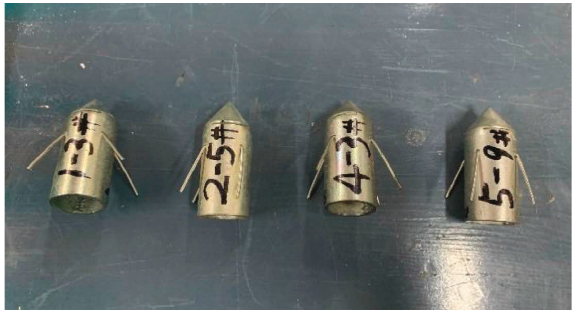
Figure 15: Measuring point device before